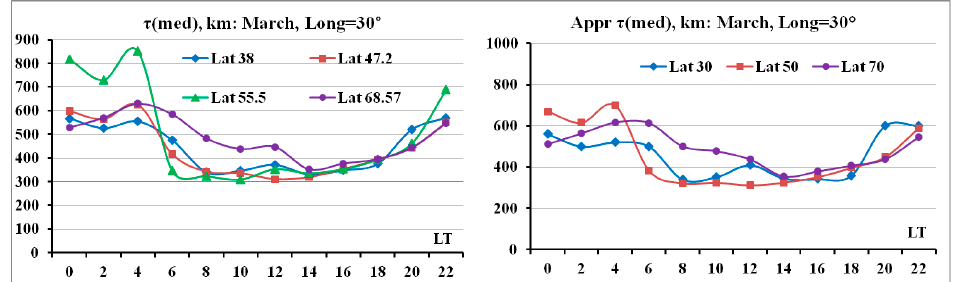
Figure 1. The diurnal variation of the initial medians of the equivalent slab thickness (the left panel) and an example of dependencies calculated for three latitudes in accordance with the polynomial approximation (the right panel).